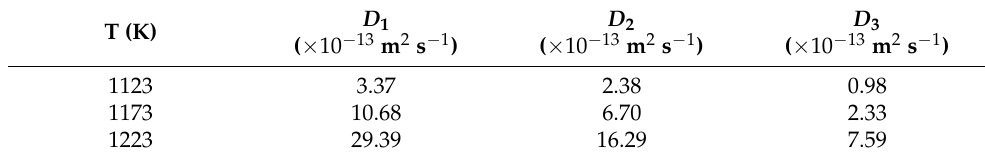
Table 4. Estimated values of boron diffusivities in nickel borides by the MDC method.